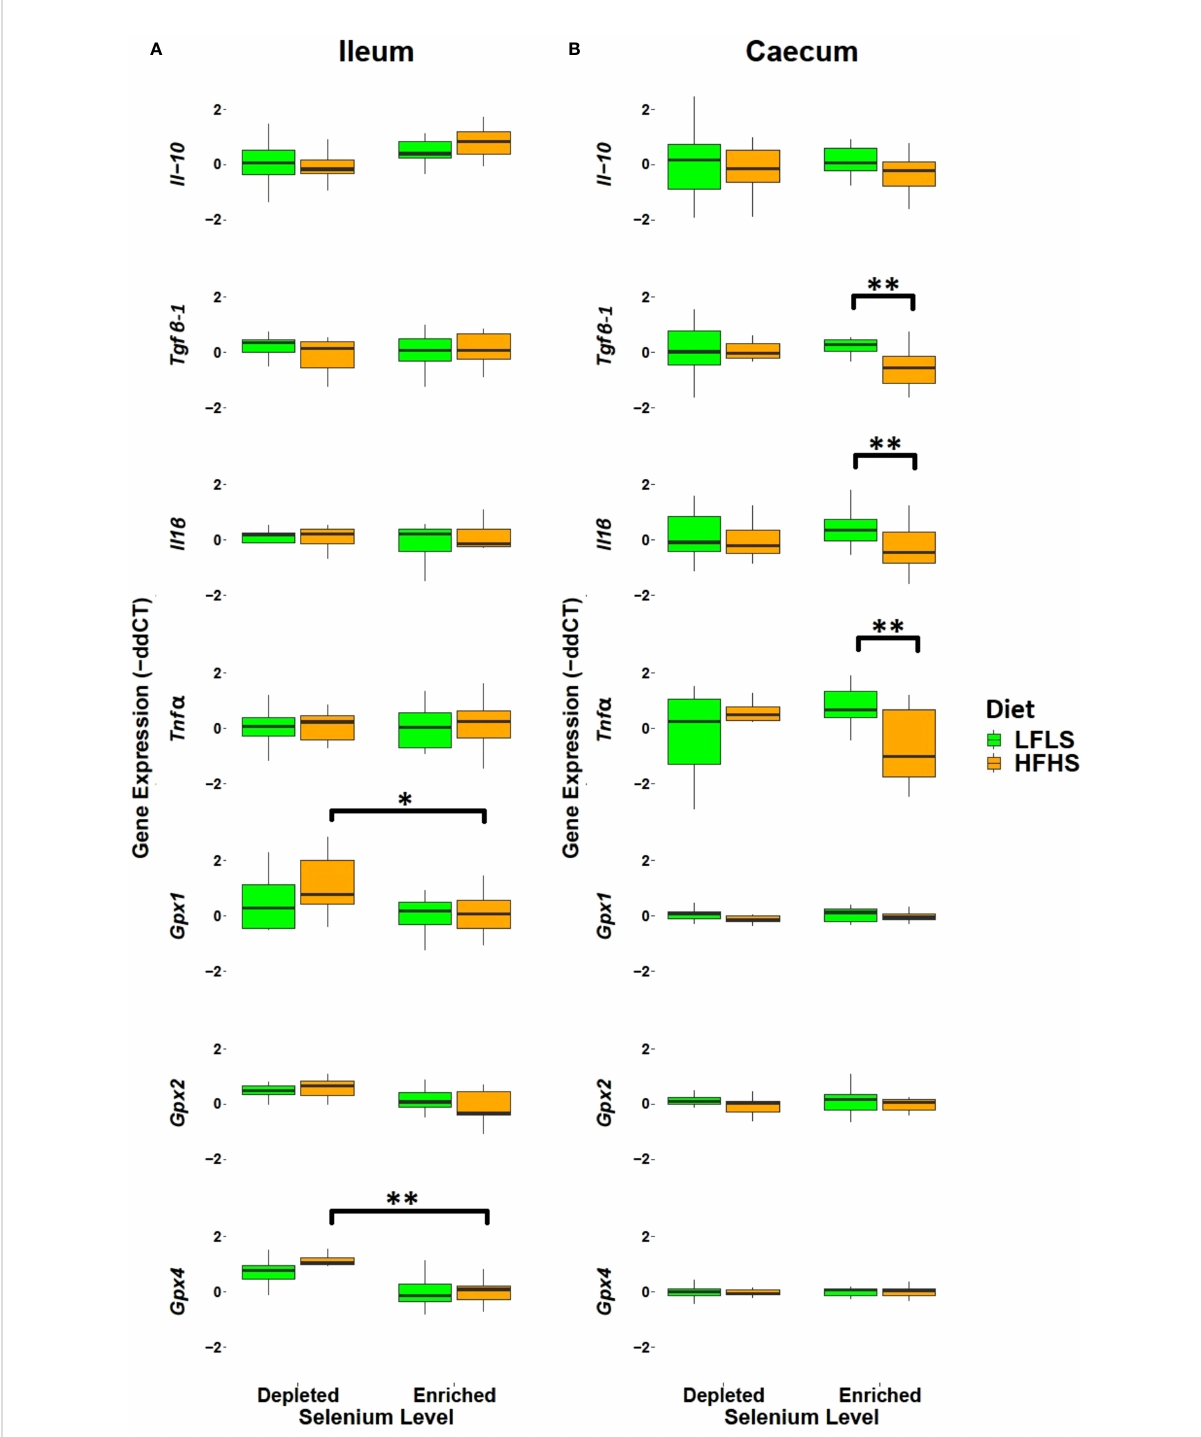
FIGURE 2 Intestinal mRNA expression of immune response and antioxidant state genes as fold change (FC) calculated using the DD C T method. (A) Ileum. (B) Caecum. Gene expression was normalized to Hprt . P values of linear contrast analysis are detailed when signi fi cant ‘ ** ’ , P < 0.01, ‘ * ’ , P<0.05 using contrast test between enriched and depleted Se levels, LFLS and HFHS formulations and the combination between Se levels and formulations. The samples were analysed at day 28 of the